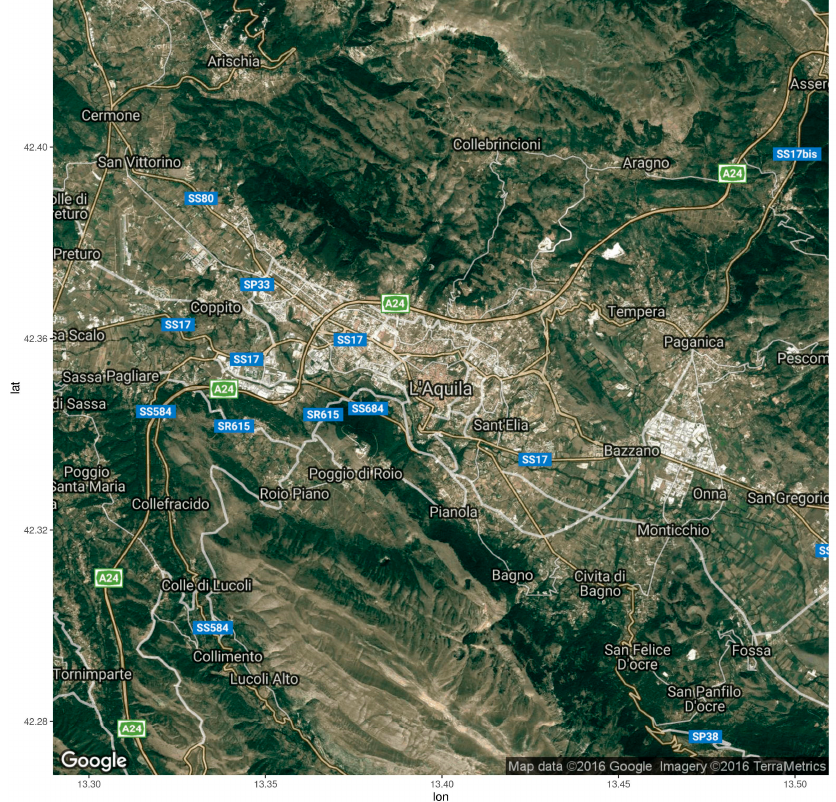
Figure 3. Study area of L’Aquila and its neighboring areas. Scenes copyrighted by Google Imagery, Mapdata, and Terrametrics. The image was reprojected from Spherical Mercator to WGS84; image is around 20 km in width.